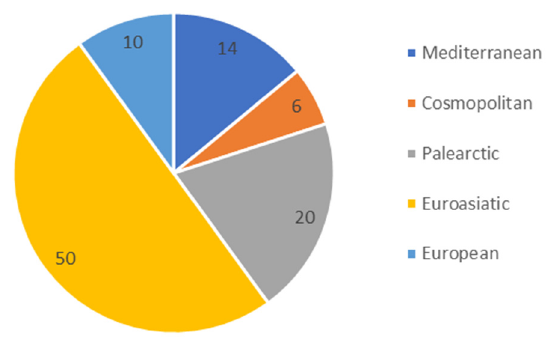
Figure 9. The chorological distribution (%) of Hemiptera Heteroptera species collected in Malpaga- Basella Nature Reserve.